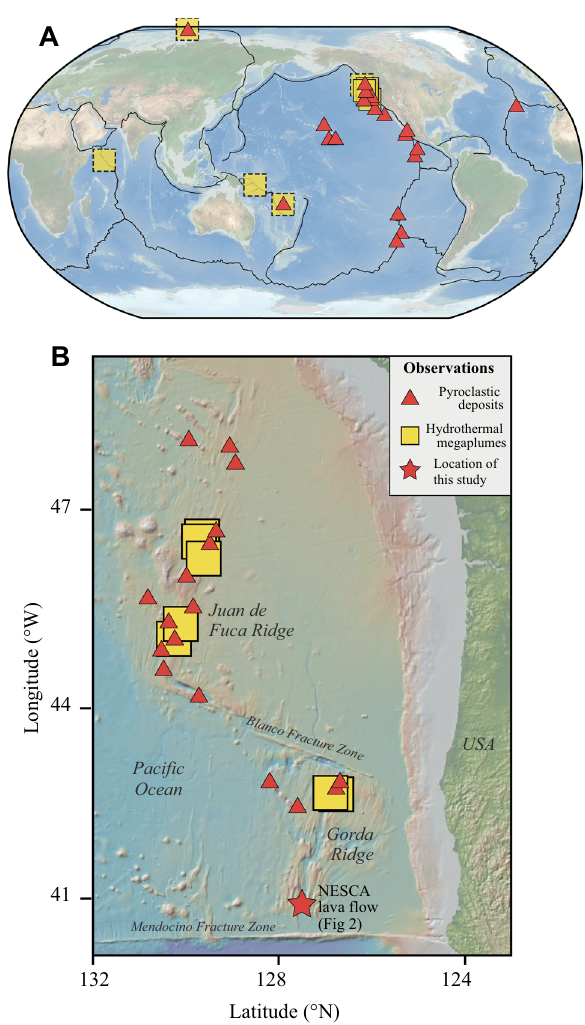
Fig. 1 Observations of hydrothermal megaplumes and deep-marine tephra deposits. Locations of megaplumes detected by water-column measurements (yellow boxes) and observed deep-marine pyroclastic tephras (red circles). Observations are shown ( A ) globally and ( B ) in the NE Paci fi c. Boxes with solid lines show plumes that have been mapped in three dimensions and therefore have known volumes (~10 – 150 km 3 ; 7 observations), while dashed lines indicate those with chemical and physical characteristics consistent with a megaplume but without a con fi dent volume estimate (5 observations). Deep-marine tephras have been discovered in multiple locations at both mid-ocean ridges (MORs) and seamounts. These encompass the global range of MOR spreading rates and water depths of up to 4 km. The preponderance of observations in the NE Paci fi c (shown in ( B )) is related to the concentration of marine research in this region. The location of the eruption and tephra deposit used for our inversion (Fig. 2) is shown by the star symbol in ( B ). Tephra observations, particularly in ( B ), are from 15 with additional data from 18 – 24 . Megaplume observations are from compilations by 5,6 . Black lines in ( A ) show tectonic plate boundaries. The base map in ( B ) from geomapp.app.org 71